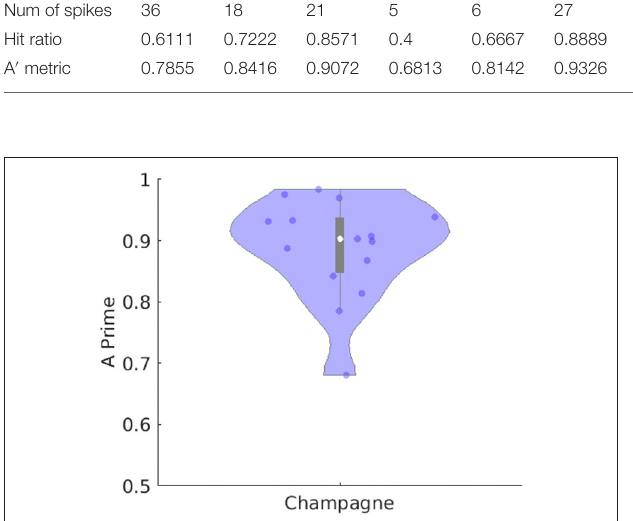
FIGURE 2 | Performance of Champagne for 14 subjects with spikes where ECDss error < 10%. The violin plot shows the distribution of A ′ metric across all subjects; each dot represents data from one person. Note that the white point represents the mean, the box subtends the middle quartiles and the whiskers the outer deciles.